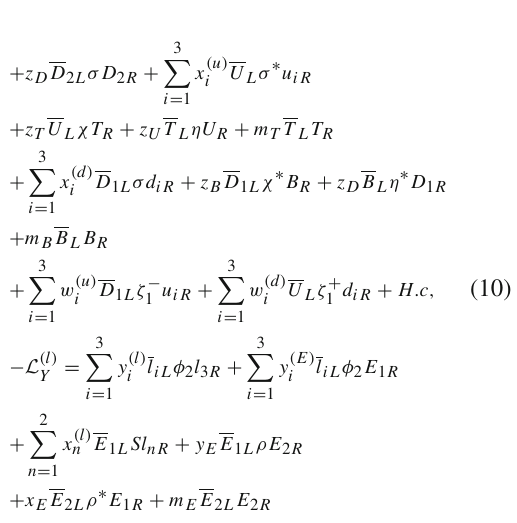
Fig. 1 Feynman diagrams contributing to the entries of the SM charged fermion mass matrices. Here, n = 1 , 2 and i , j = 1 , 2 ,